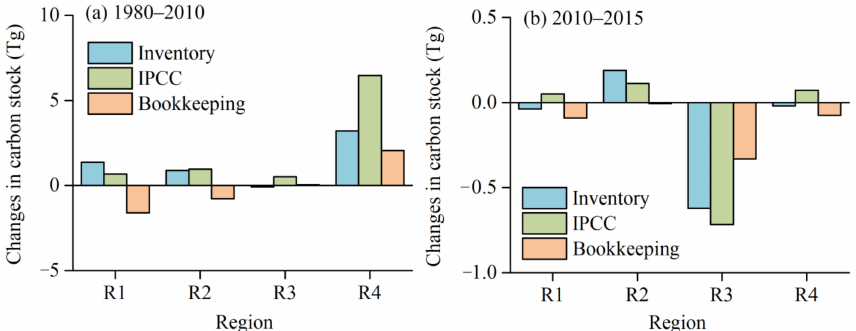
Figure 5. Henan Province’s terrestrial system carbon stock change driven by land use type conversion between 1980 and 2010 and between 2010 and 2015 (bookkeeping in legend denotes the moderate scenario; the negative sign refers to carbon emission; R1–R4 refer to 4 ecogeographical regions).